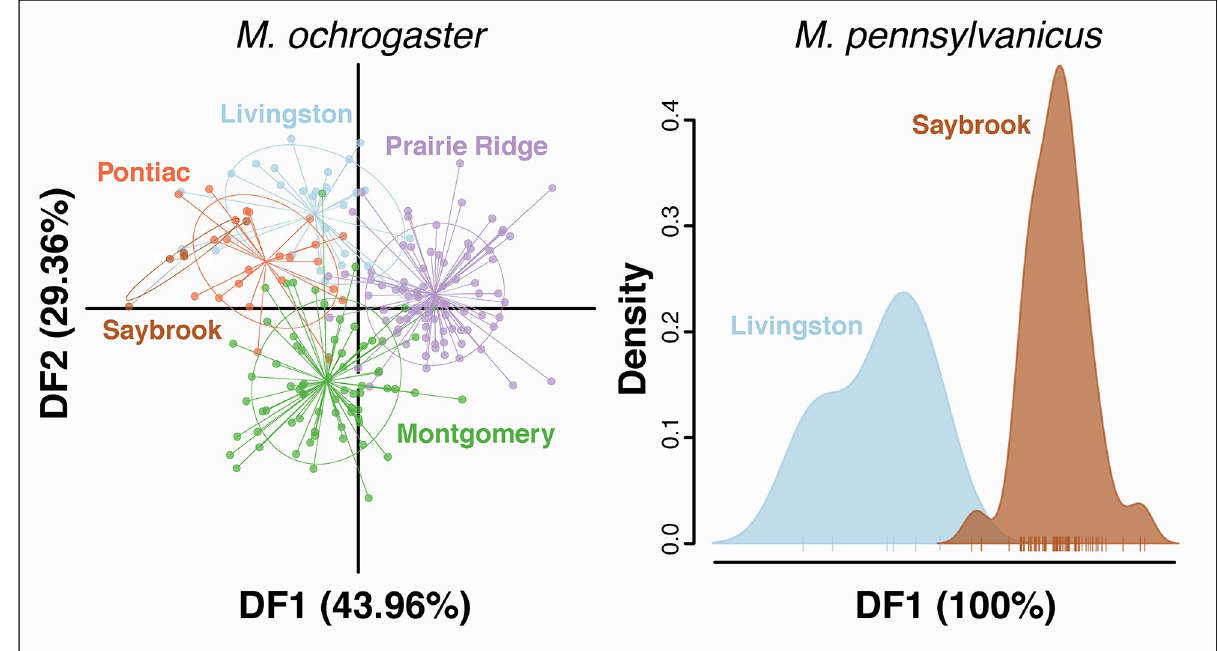
Fig 2. Discriminant analyses of principal components (DAPC) for M . ochrogaster and M . pennsylvanicus . Genetic clusters found at five SAFE sites: Livingston, Montgomery, Pontiac, Prairie Ridge, and Saybrook. Data derived from 15 microsatellite loci. Colors reflect unique sites and are consistent across species; individuals are represented as points for M . ochrogaster and ticks for M . pennsylvanicus . The percentage of variation from the discriminant analysis captured by each discriminant function axis (DF) is in parentheses.